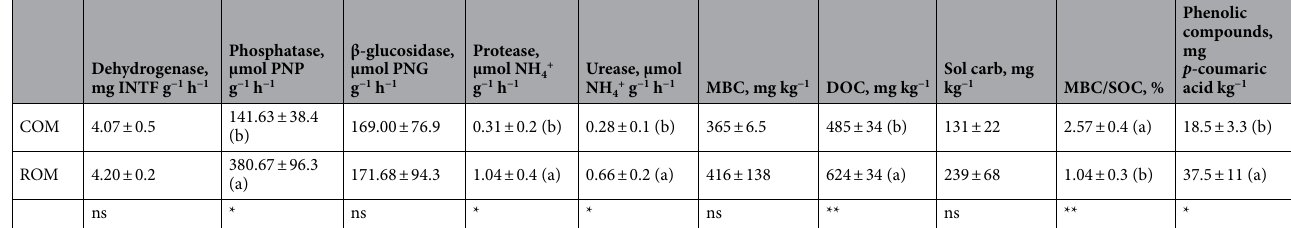
Table 4. Enzymatic activities, microbial biomass C and dissolved organic C of Locone Lake soils (mean ± standard deviation of three replicates). COM control soil, ROM Robinia pseudoacacia L. soil, MBC microbial biomass carbon, DOC dissolved organic carbon, Sol. carb. soluble carbohydrates, SOC soil organic carbon. The values in each column followed by a different letter are significantly different according to HSD test. *Significant at p ≤ 0.05; **significant at p ≤ 0.01; ns not